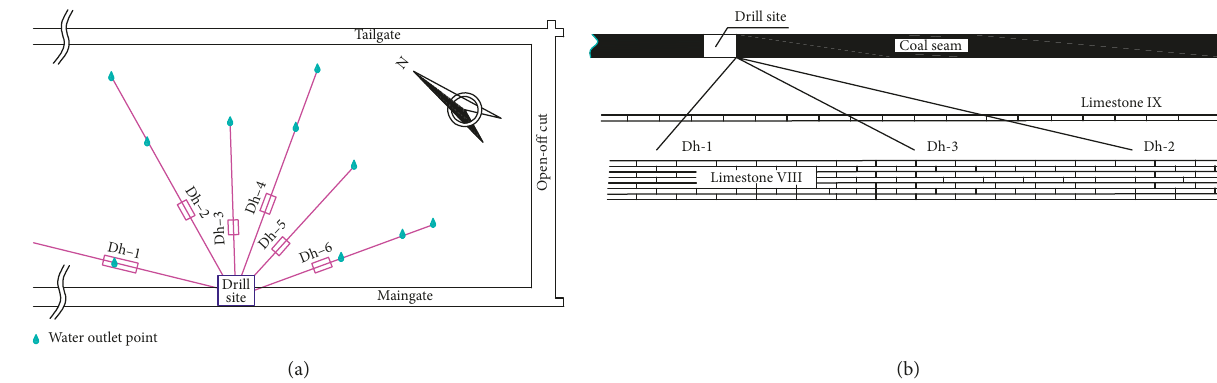
Figure 11: Schematic diagram of (a) grouting casing pipes layout and (b) grouting casing pipes layout section.